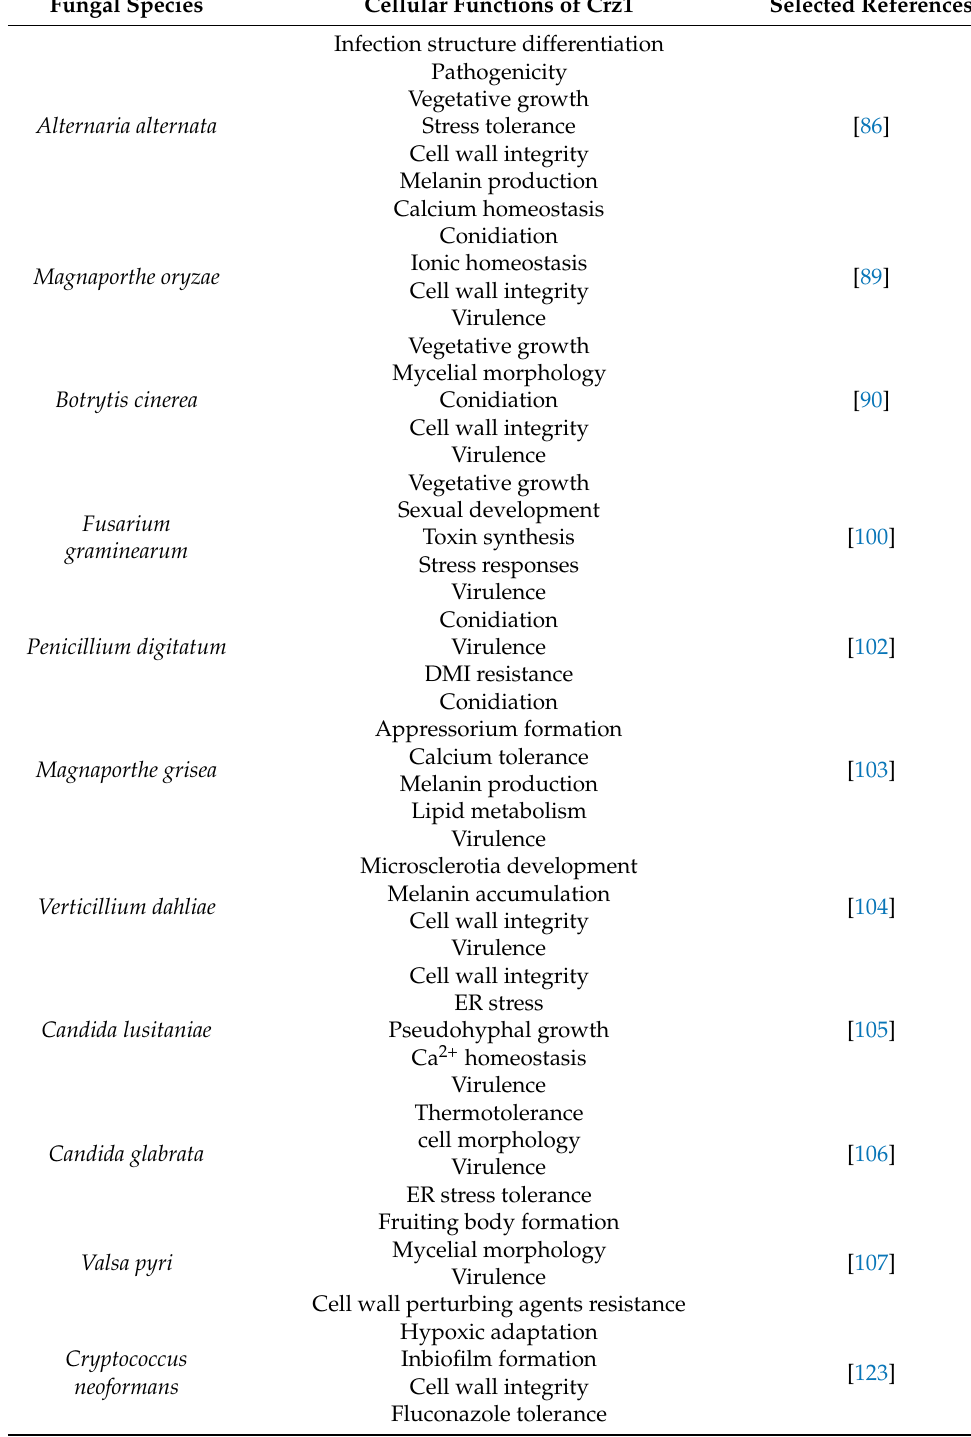
Table 1. Regulatory roles of transcription factor Crz1 in